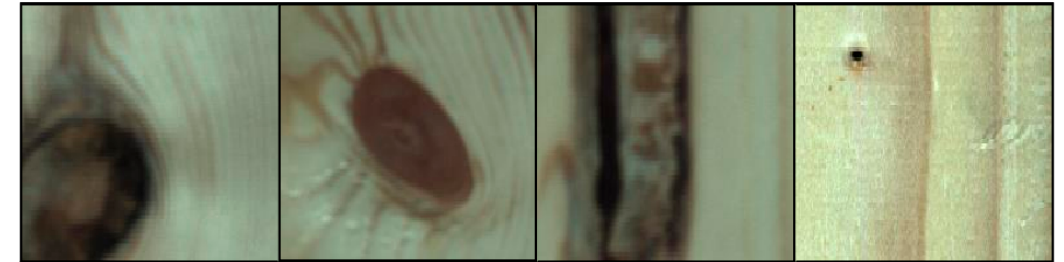
Figure 1. Common defects of solid wood such as dead-knot, live-knot and decay.